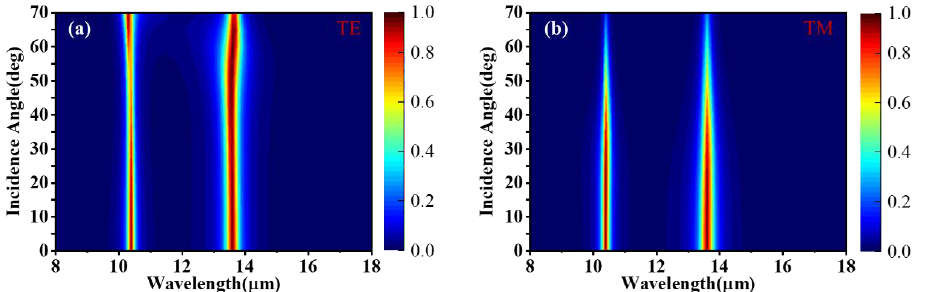
Figure 7. Absorption spectra for ( a ) transverse electric wave (TE) polarization and ( b ) transverse magnetic wave (TM) polarization as a function of the incidence angle.